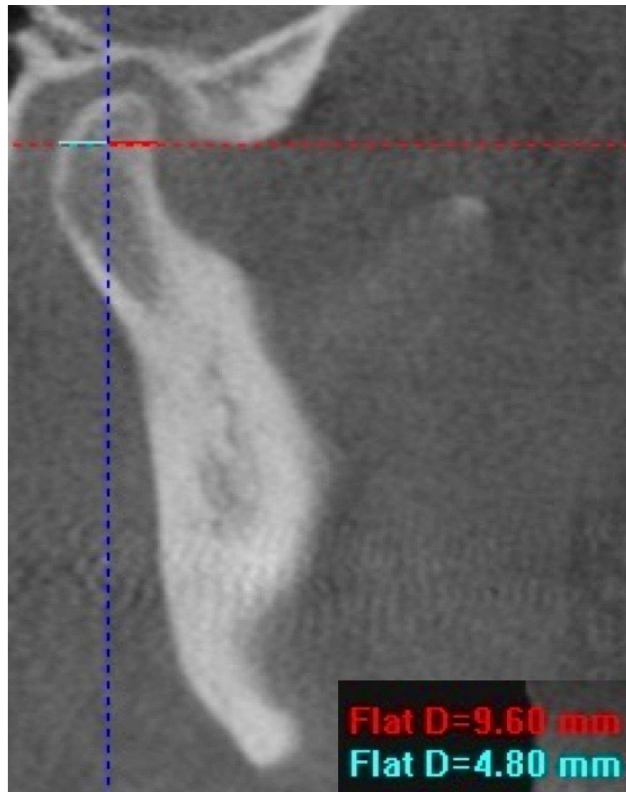
Fig.1. Standardization of the positioning in sagittal